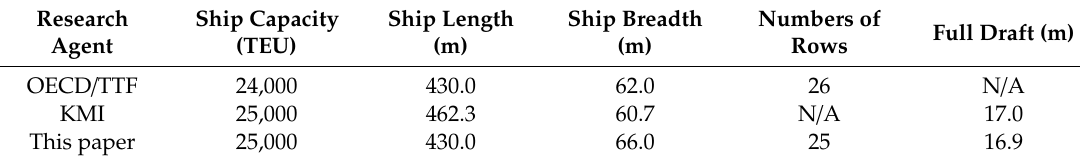
Table 7. Comparison between Dimensions of 25,000 TEU